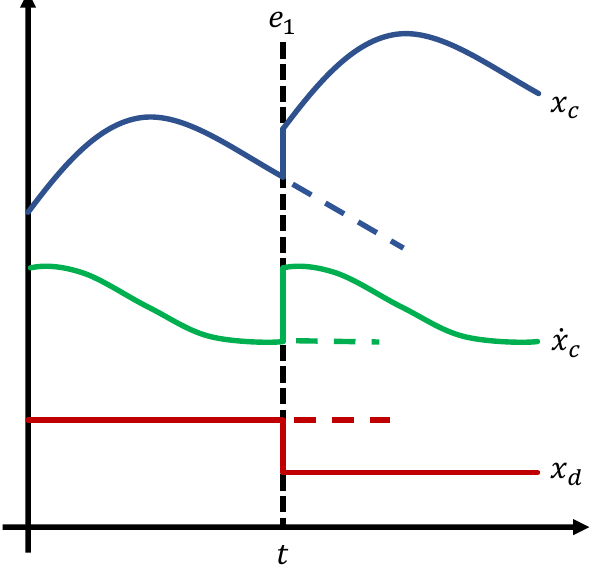
Figure 1. Exemplified simulation of an ME-FMU with events (discontinuous ODE). The single (piecewise) continuous system state x c (blue) and state derivative ˙ x c may depend on a discrete system state x d (red), which is generally unknown for FMUs. Not handling events such as e 1 (black- dashed), leads to incorrect system values (blue-, green-, red-dashed) because the system state is not updated